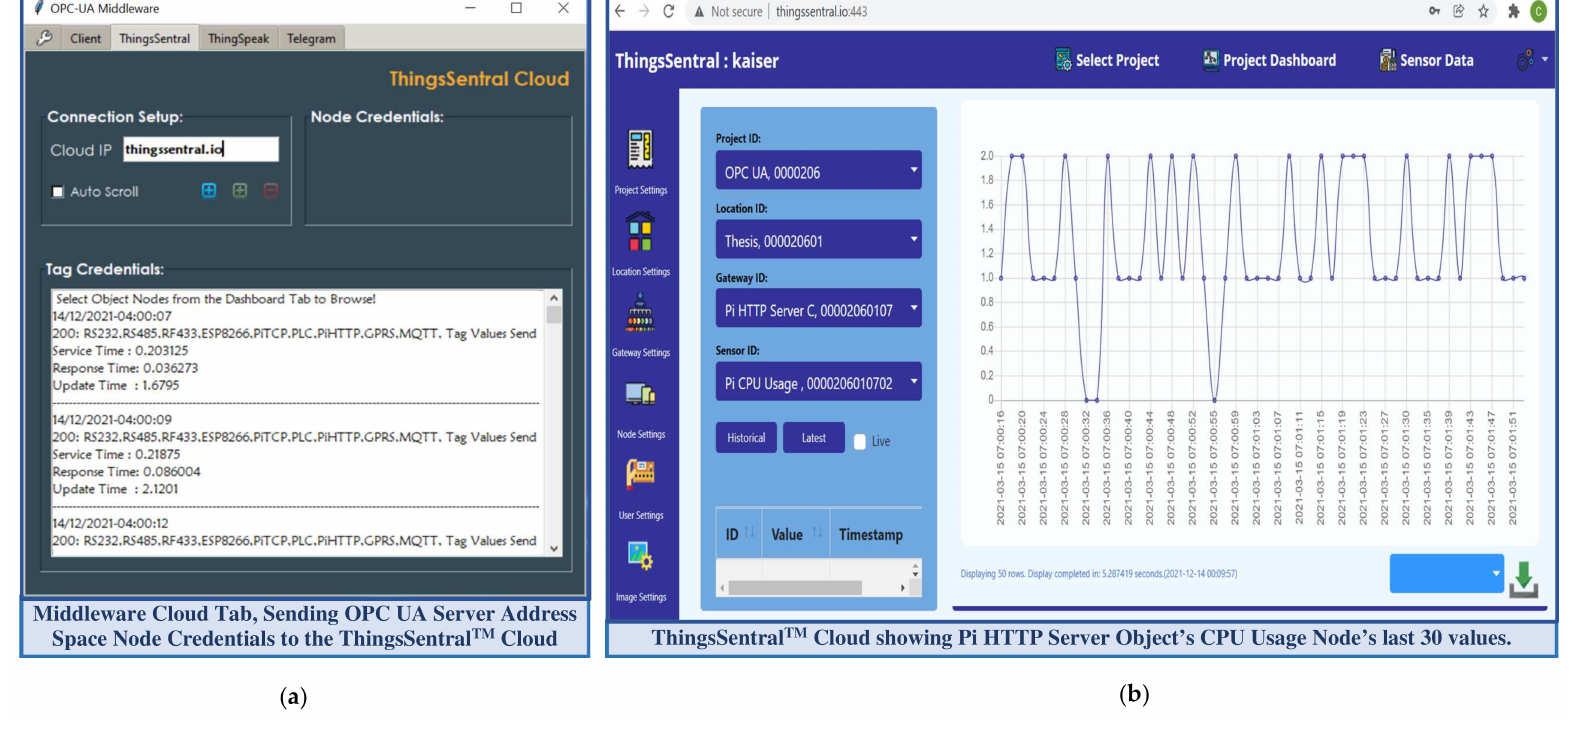
Figure 6. ( a ) Middleware application ThingsSentral TM tab; ( b ) data monitoring in ThingsSentral TM